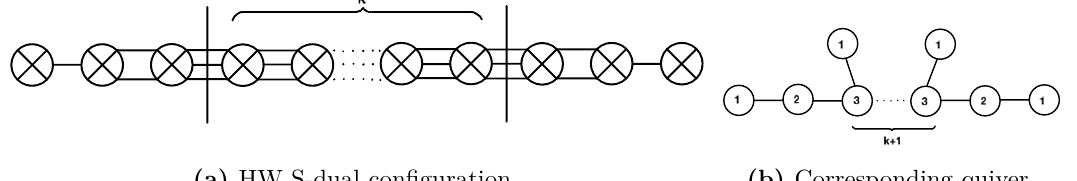
Figure 5. B-theory.